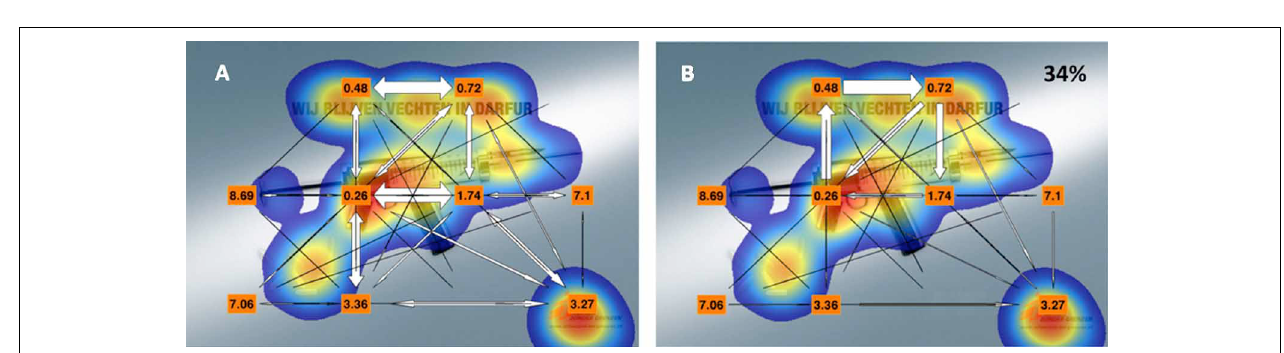
orange labels denote T 50 . The gun is fixated first and many transitions go to the text. Later there are transitions to the bullets (left) and the brand logo (right). Panel (D) . shows a visualization of the net transition matrix. Only 8% of the transitions are in this figure, indicating that gaze guidance is not very strong in this